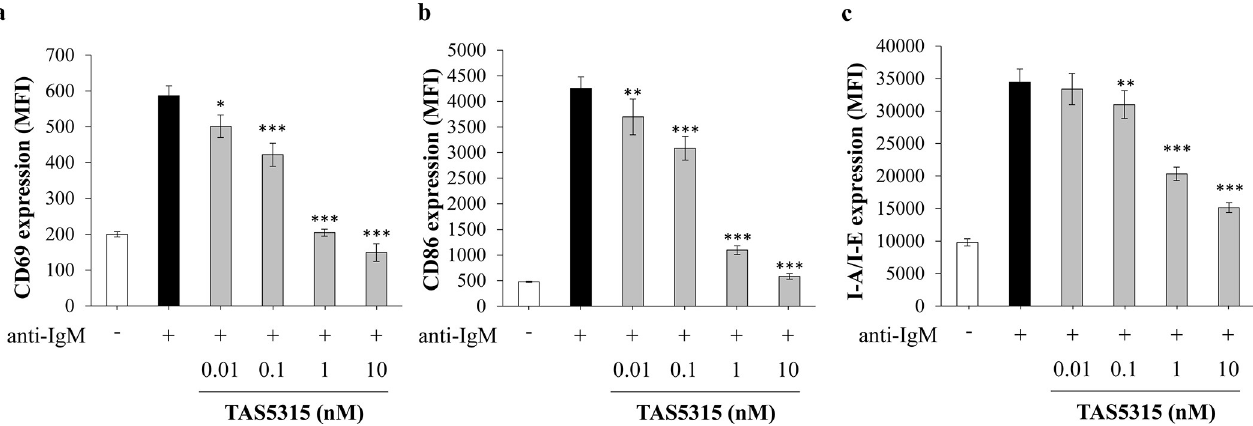
Fig 2. TAS5315 inhibits cell surface expressions of CD69, CD86, and MHC class II on mouse splenic B cells. (a–c) Cell surface expressions of CD69, CD86, and I-A/I-E on mouse B220 + B lymphocytes stimulated with anti-IgM (5 μ g/mL). TAS5315 treatment was performed simultaneously with anti-IgM stimulation. All experiments were performed in triplicates, and the numerical data are presented as mean ± SD. � P < 0.05, �� P < 0.01, ��� P < 0.001 compared with the DMSO group (Dunnett test for TAS5315 groups).